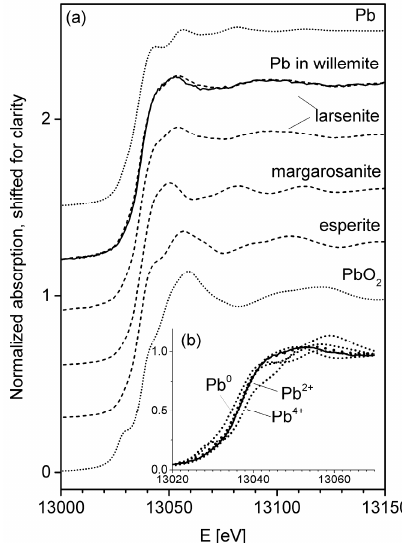
Figure 10. ( a ) Comparison of the averaged Pb L 3 XANES spectrum for Pb containing Tres Marias willemite compared with the spectra of elemental Pb, of larsenite [PbZnSiO 4 ] (Smithsonian C6174), margarosanite [Pb(Ca,Mn 2+ ) 2 (Si 3 O 9 )] (Smithsonian C6175), and esperite [PbCa 2 (ZnSiO 4 ) 3 ] (Smithsonian R18305) as Pb 2+ references, and PbO 2 as Pb 4+ reference. The inset ( b ) demonstrates the edge shift from elemental Pb via Pb 2+ minerals to Pb 4+ in PbO 2 . Sample and reference spectra were measured in fluorescence and transmission mode,